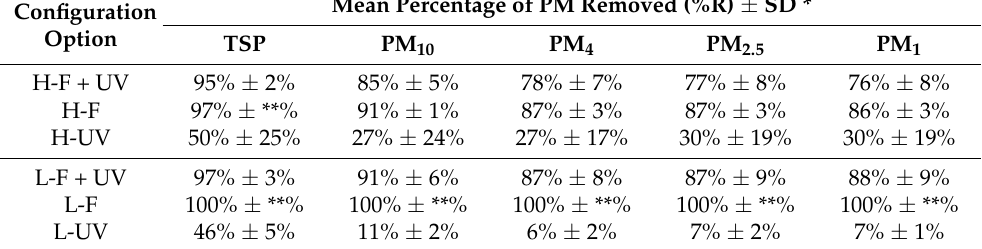
Table 3. The mean percentage mitigation of PM concentrations between the inlet and treated air under different configuration options. The performance metric is the percent reduction defined as the relative difference between inlet and treated concentrations under different configuration options. The percentage is the average of three or four trials conducted for each configuration. The loading of average TSP in the inlet air of each trial varied from 97 µ g/m 3 to 230 µ g/m 3 . Configuration